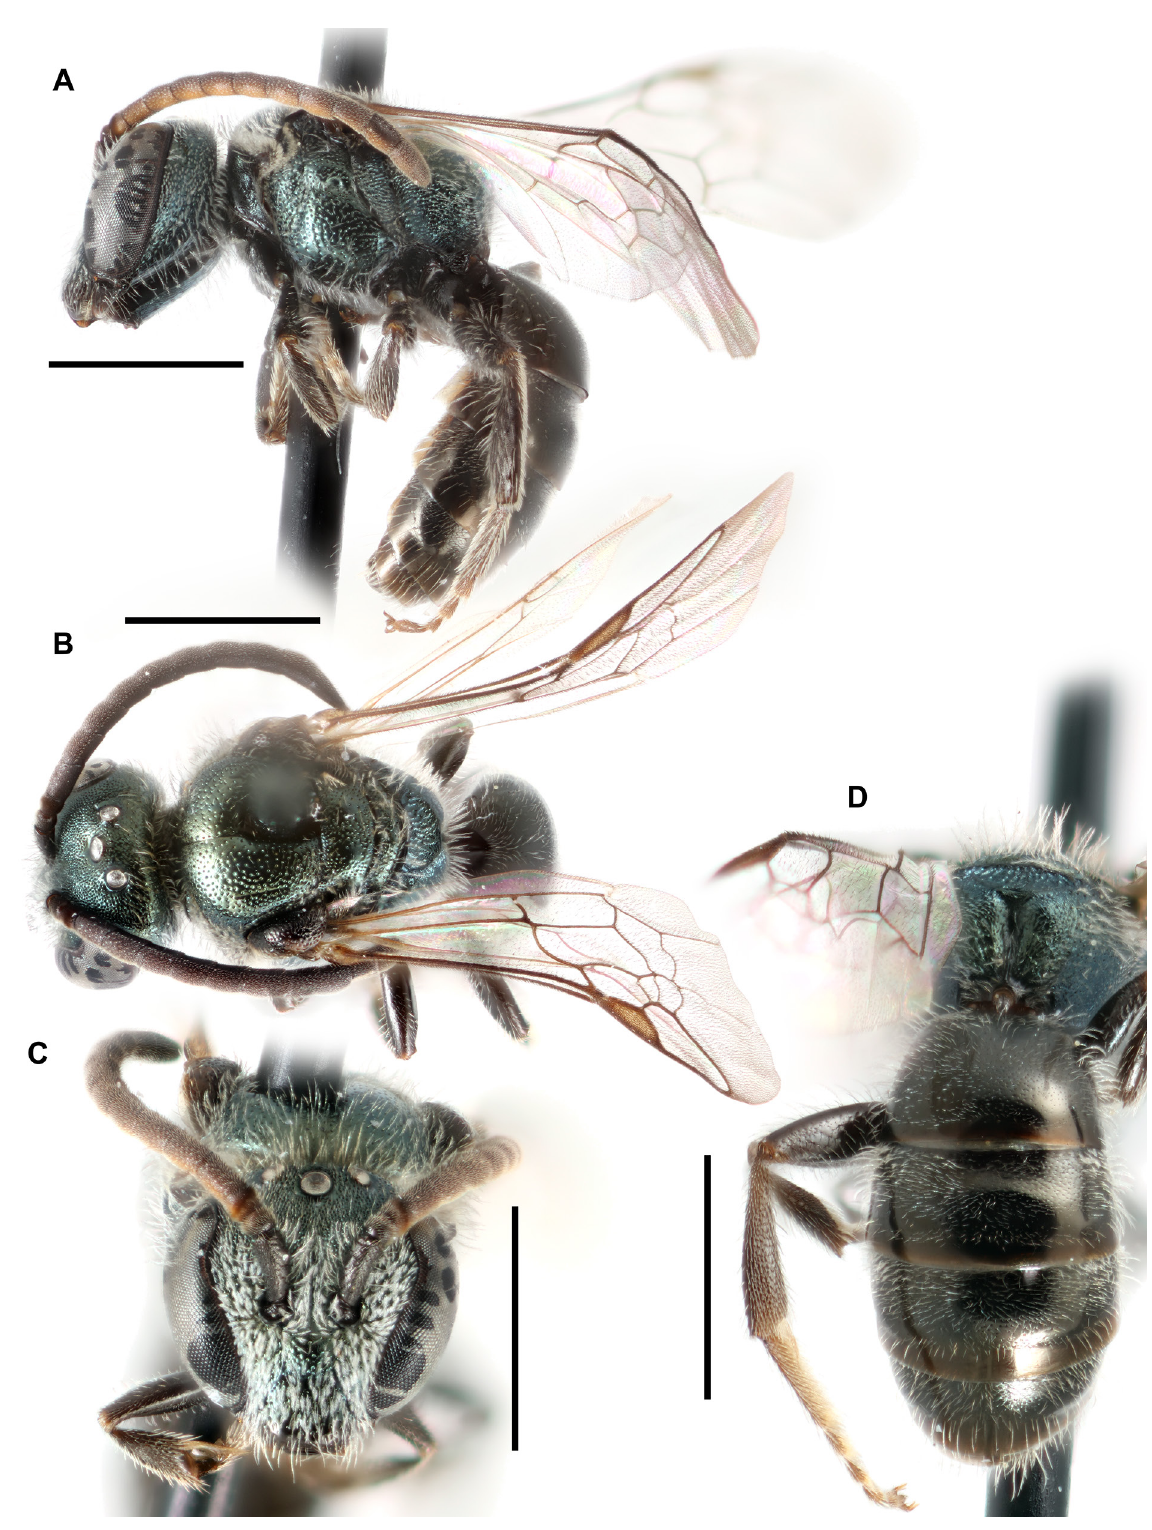
Fig. 66. Lasioglossum ( D .) stictaspis (Sandhouse, 1923), ♂, Mexico morph (WRME). A . Lateral habitus. B . Dorsal habitus. C . Face. D . Metasoma and propodeum. Scale bars = 1